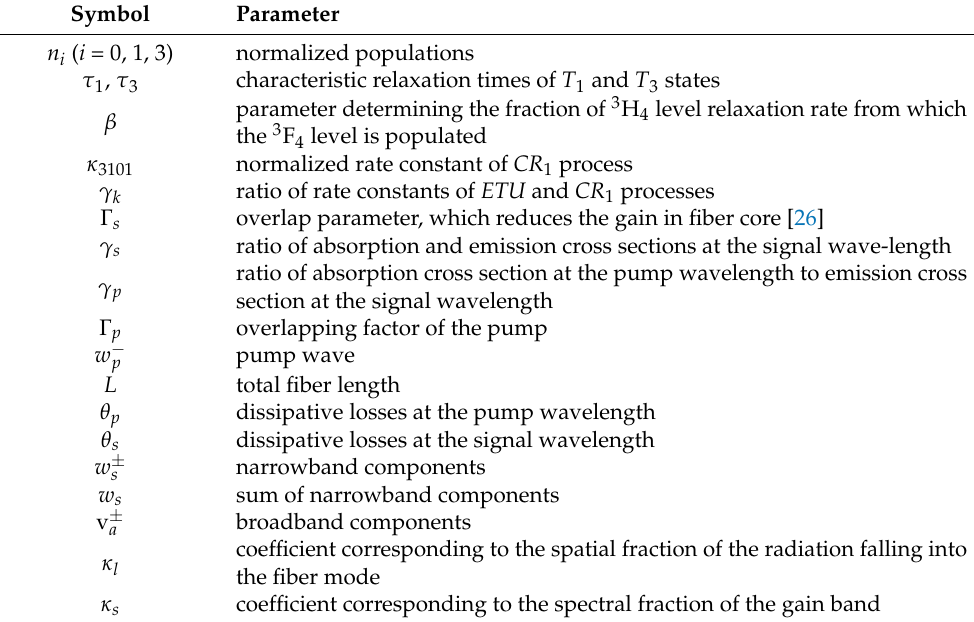
Table 1. Parameters used in numerical